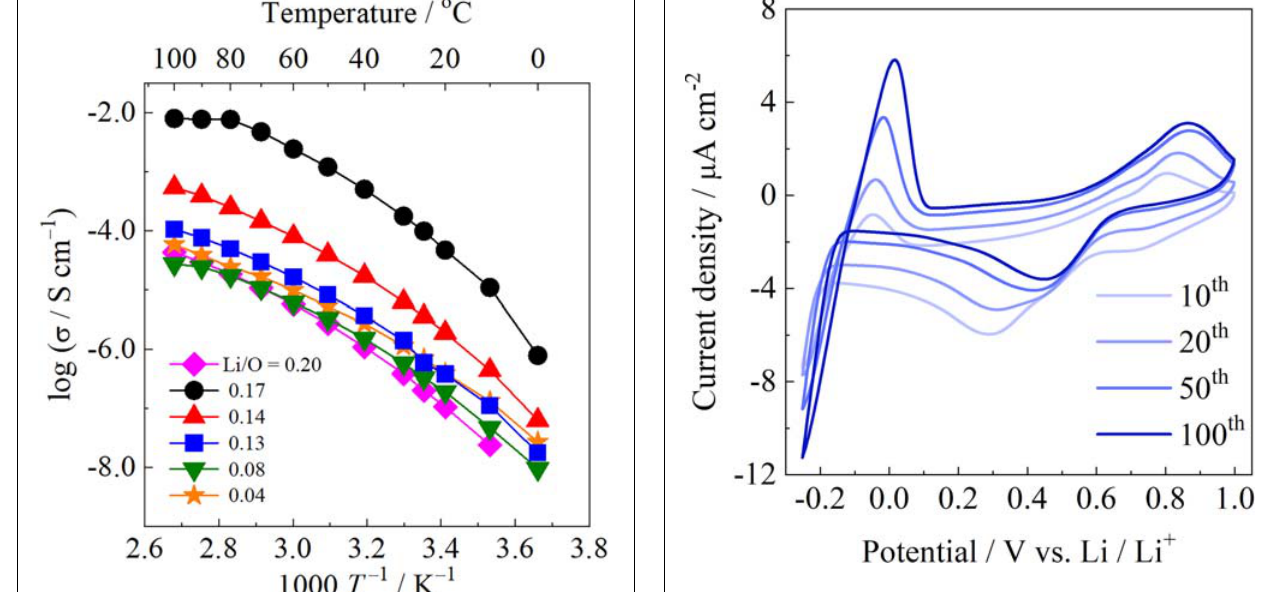
FIGURE 10 | CV curves of SME/LiTFSA (Li/O = 0.17) over 100 cycles at a scan rate of 10 mV s − 1 at 60 ◦